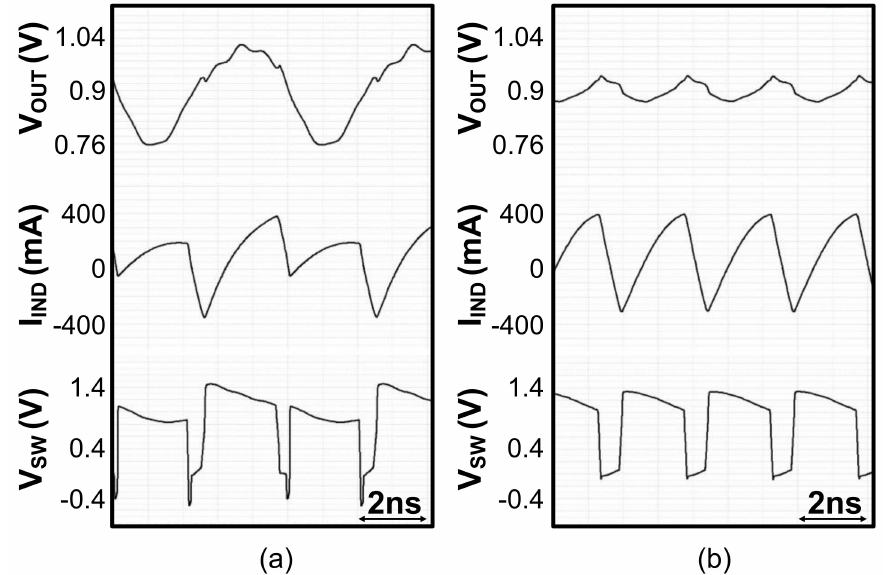
Figure 8. Simulated waveforms of the soft-switching hybrid DC-DC converter in steady state: ( a ) with the conventional 1-phase SC and ( b ) with the proposed 2-phase SC.